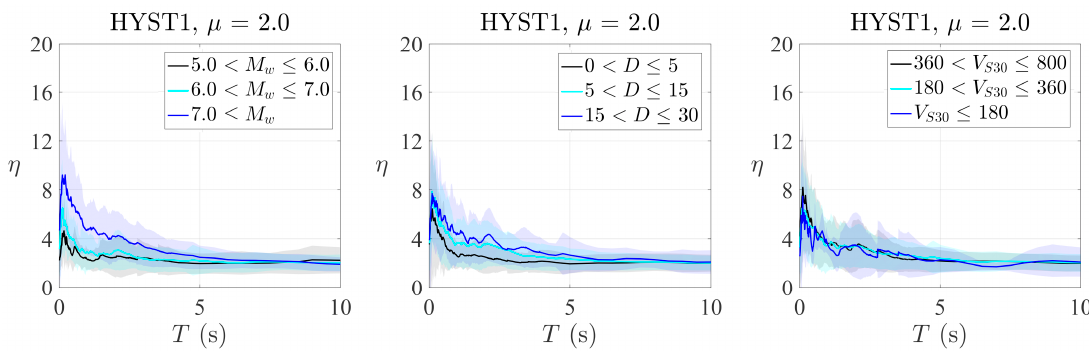
Figure 7. Spectra of the cumulative plastic deformation ratio η for the hysteretic model HYST1 and ductility level μ equal to 2 considering different subsets of seismic records (filled area: envelope of the spectra; solid line: mean spectrum).